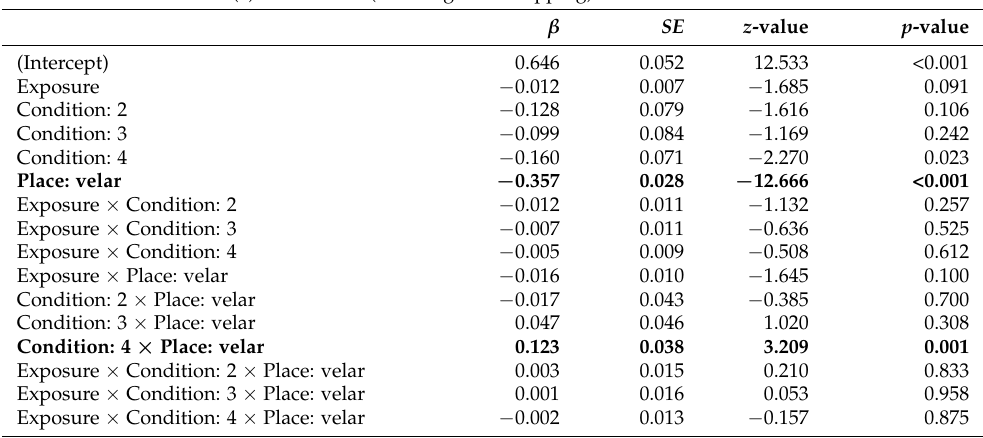
Table A1. Fixed-effect coefficients in Model 1 of the log odds of voiceless identification (HeardVoice- less). Model formula: HeardVoiceless ~ Exposure * Condition * Place + (1 | Participant). Exposure was coded as continuous and centered; Condition as categorical, with four alternate reference levels (a–d); and Place as categorical. Significant effects are